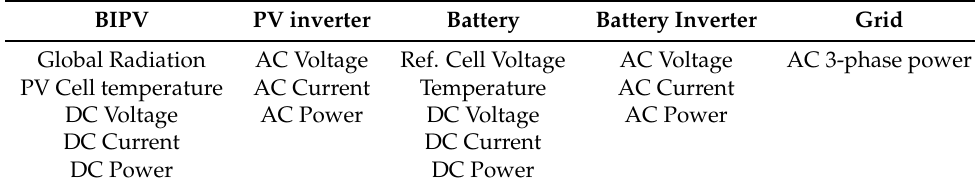
Table 4. Monitored variables during the demonstrator operation. BIPV: Building Integrated